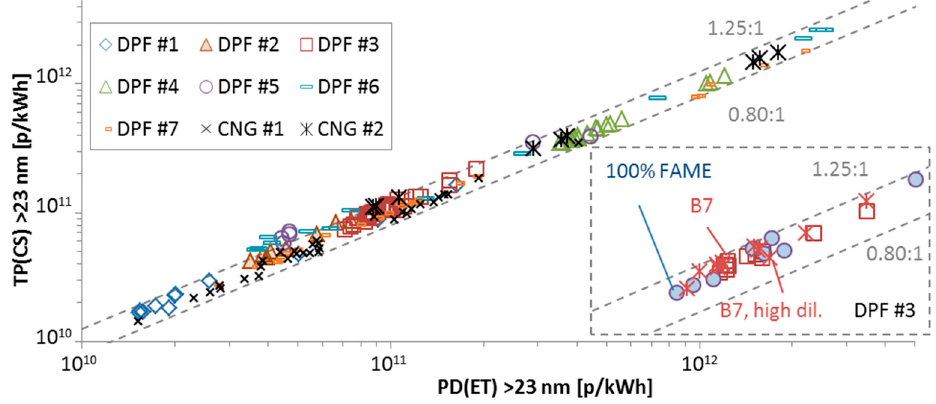
Figure B1. Comparison of “Golden” system TP(CS) with instruments at proportional partial flow dilution systems PD(ET) with the CPCs measuring >23 nm. B7 = Diesel with 7% biofuel; CNG = Compressed natural gas; DPF = Diesel particulate filter; FAME = Fatty acid methyl esters.